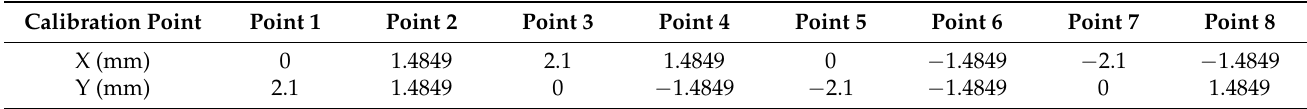
Figure 5. Distribution of gas flow velocity at the gas outlet boundary of the single gas chamber die. ( a ) Gas inlet flow velocity of 2 m/s; ( b ) Gas inlet flow velocity of 4 m/s; ( c ) Gas inlet flow velocity of 6 m/s; ( d ) Gas inlet flow velocity of 8 m/s.